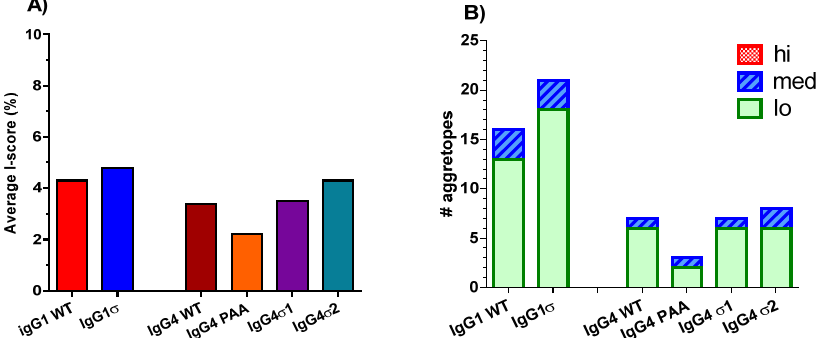
Figure 11. ImmunoFilter TM analyses of the human IgG variants. The amino acid sequences for the different variants were analyzed for predicted immunogenicity in silico using ImmunoFilter TM v2.7. ( A ) IScores summary which approximated the percent of US population expected to have a human leukocyte antigen (HLA) allele predicted to bind a nine-mer peptide within a sequence of interest. ( B ) The number of individual agretopes and their associated risk potential based on the percent of the population expected to have an allele predicted to bind each agretope (low (lo) = 10–25%, medium (med) = 25–50%, and high (hi) = over 50% of the U.S. population). Resulting IScores were averaged across all loci. Higher IScores indicate a higher predicted immunogenicity